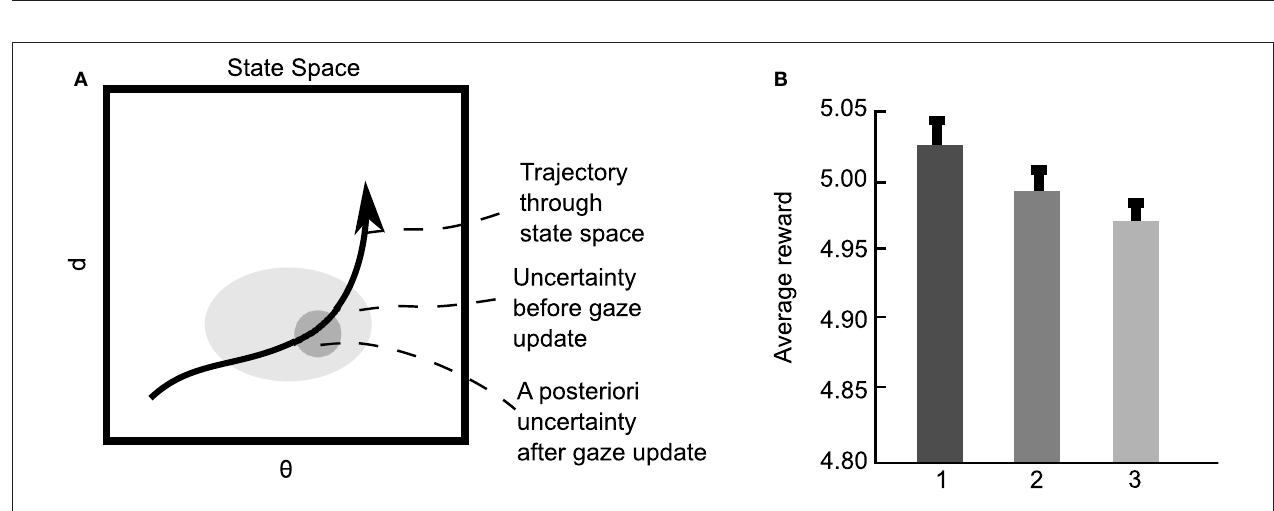
Figure 3 | Module-based gaze allocation. Modules compete for gaze in order to update their measurements. (A) A caricature of the basic method for a given module.The trajectory through the agent’s state space is estimated using Kalman filter that propagates estimates in the absence of measurements and, as a consequence, build up uncertainty (large shaded